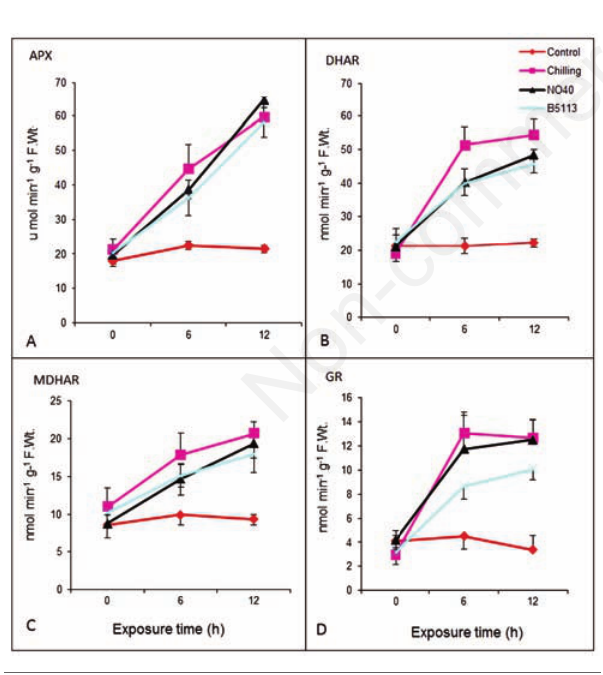
Figure 3. Effect of bacterial priming on the activity of redox enzymes in the leaves of cold stressed wheat Effects of priming with B. amyloliquefaciens 5113 or A. brasilense NO40 on the activity of enzymes of the ascorbate-glutathione redox cycle were tested in the leaves of wheat seedlings (cv. Sids1) exposed to −5°C for 0, 6 and 12 h. A) Ascorbate Peroxidase (APX) (µmol min−1 g −1 fresh weight); B) dehydroascorbate reductase (DHAR); C) mono-dehydroascorbate reductase (MDHAR); and D) glu- tathione reductase (GR) (nmol min−1 g −1 fresh weight). Bars indicate standard errors between 3 replicates.